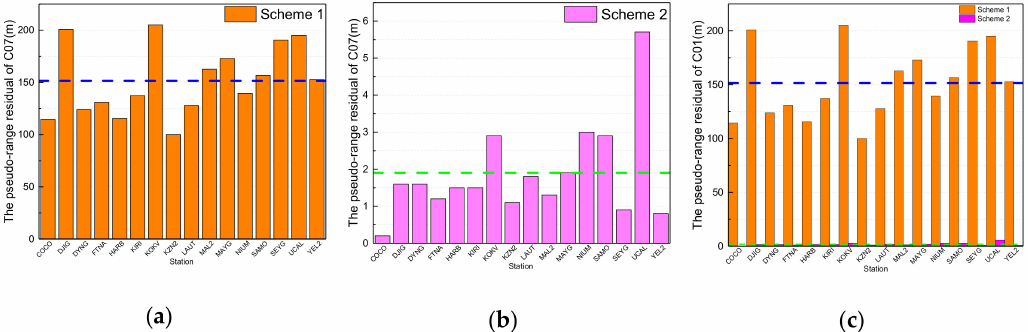
Figure 5. Pseudo-range residuals of stations for C07 in the first adjustment for data processing on 16 October 2017: residuals from precise orbit determination according to ( a ) scheme 1 and ( b ) scheme 2 and ( c ) comparison between Figure